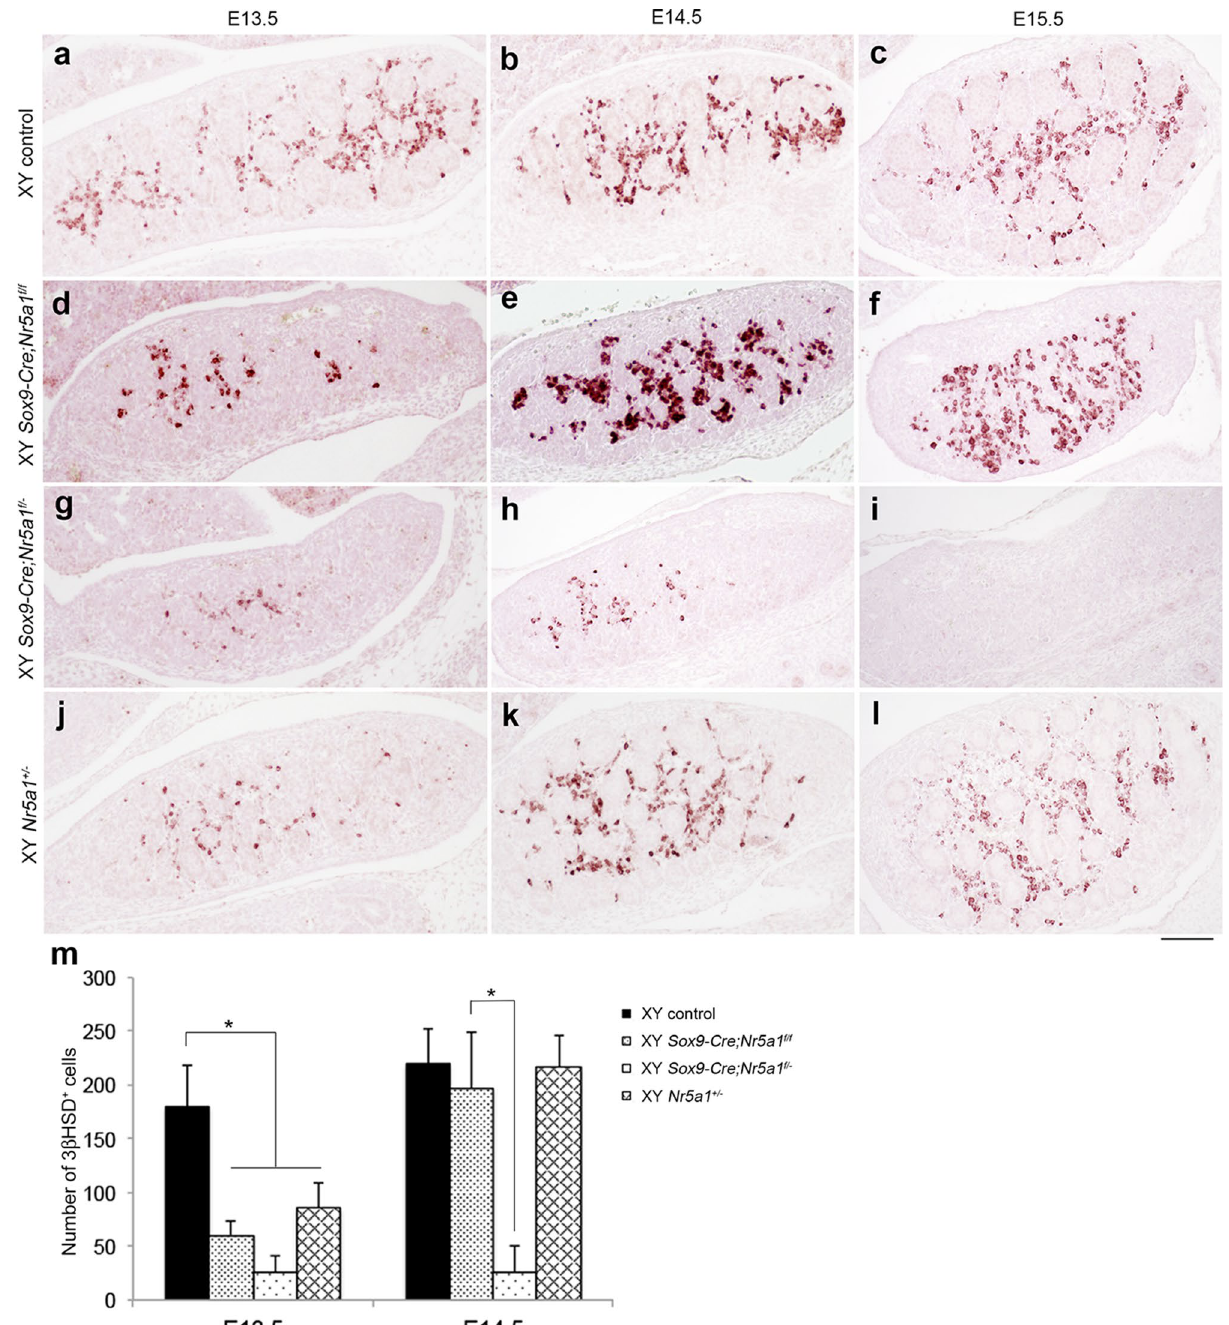
Figure 4. Leydig cell differentiation in XY Sox9-Cre - Nr5a1 cKO gonads. IHC for Leydig cell marker, 3βHSD in gonads of XY control ( a – c ), XY Sox9-Cre;Nr5a1f. /f ( d – f ), XY Sox9-Cre;Nr5a1f. /− ( g – i ), and XY Nr5a1 + /− ( j – l ) mice at E13.5, E14.5, and E15.5 (left, middle, and right panels, respectively). Ventral, anterior, and posterior sides of gonad are upwards, right, and left, respectively. Scale bar, 100 μm. ( m ) Numbers of 3βHSD + cells in gonadal section determined by IHC. Data are shown as means ± SEM (n = 3). * P <